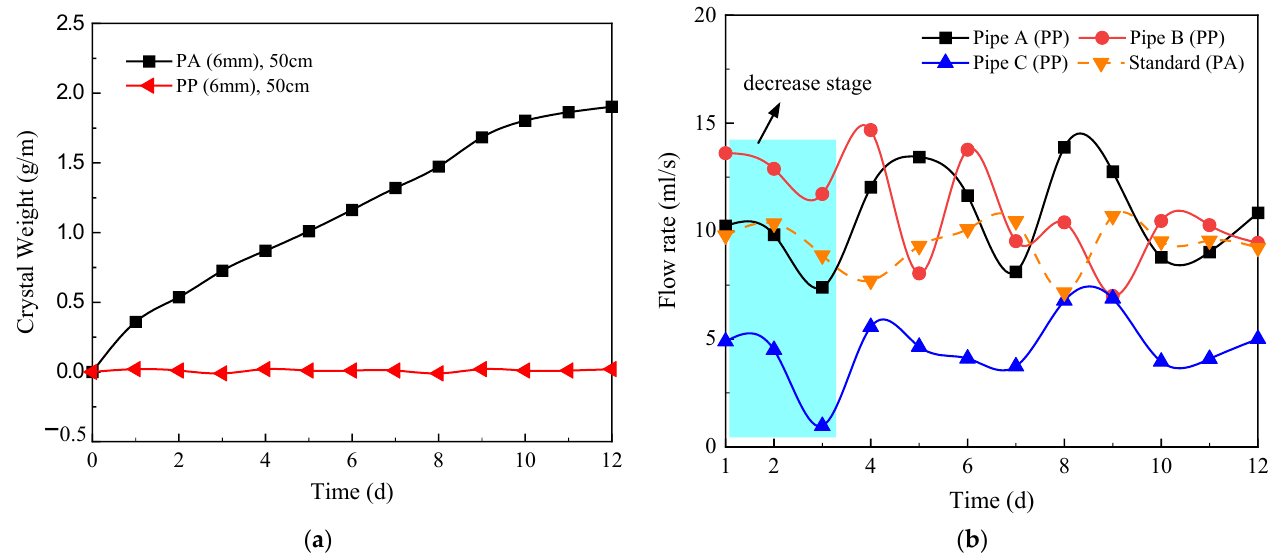
Figure 15. Variation of crystallization rate and flow rates with time of drainage pipes of different materials. ( a ) Crystallization rate curves. ( b ) Flow rate curves.